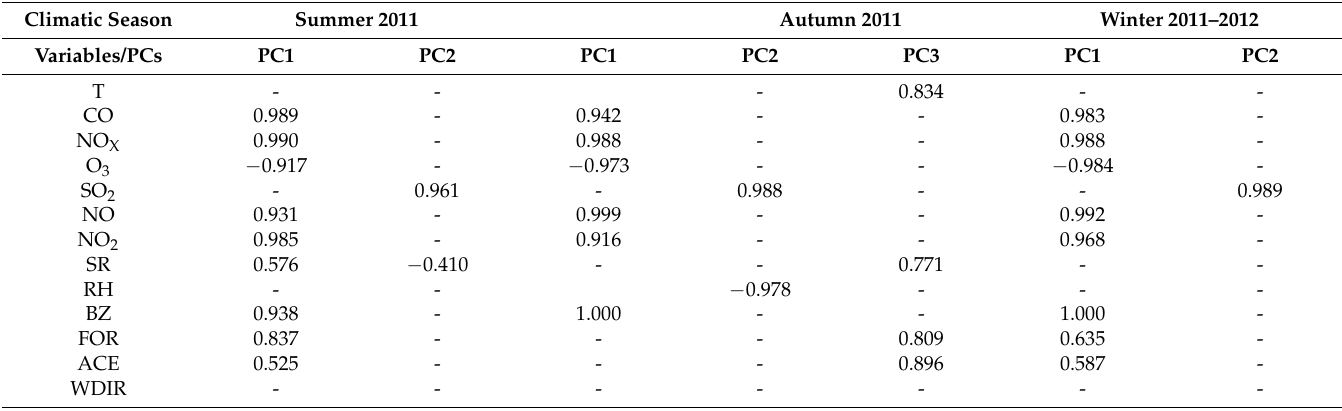
Table 8. Factor loadings for benzene, formaldehyde, acetaldehyde, criteria air pollutants, and meteorological parameters for the three sampling periods (only significant factor loadings are shown). TEMP: temperature; RH: relative humidity; SR: solar radiation; BZ: benzene; FOR: formaldehyde; ACE: acetaldehyde; WDIR: wind direction. Only statistically significant loadings are